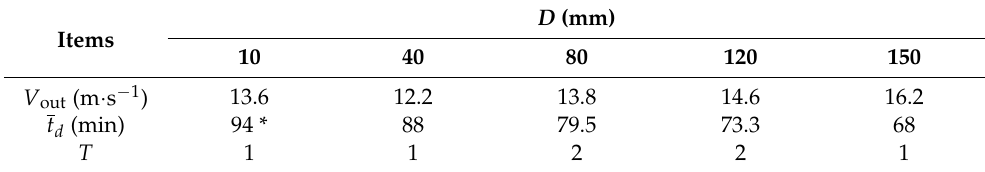
Table 9. The wind speed at which the floating balls were blown out of the